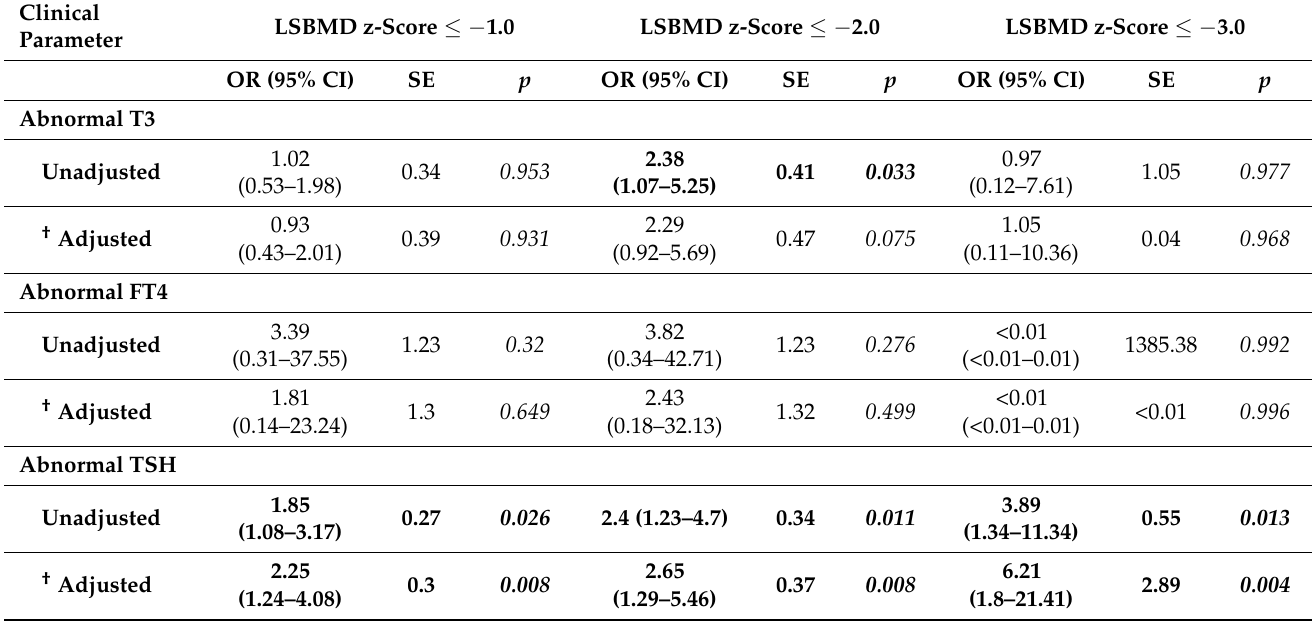
Table 4. Logistic regression analyses of abnormal triiodothyronine, free thyroxine, and thyrotropin when using decreased lumbar spine bone mineral density z-scores as dependent